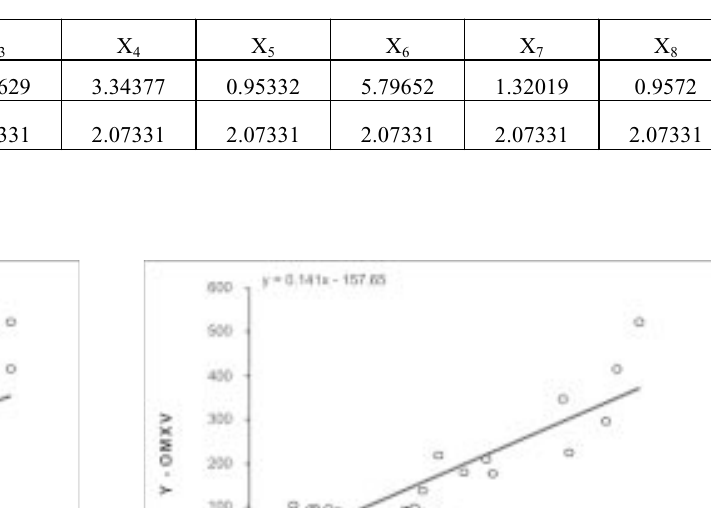
Table 5 . Fisher coefficients of single linear regression analysis